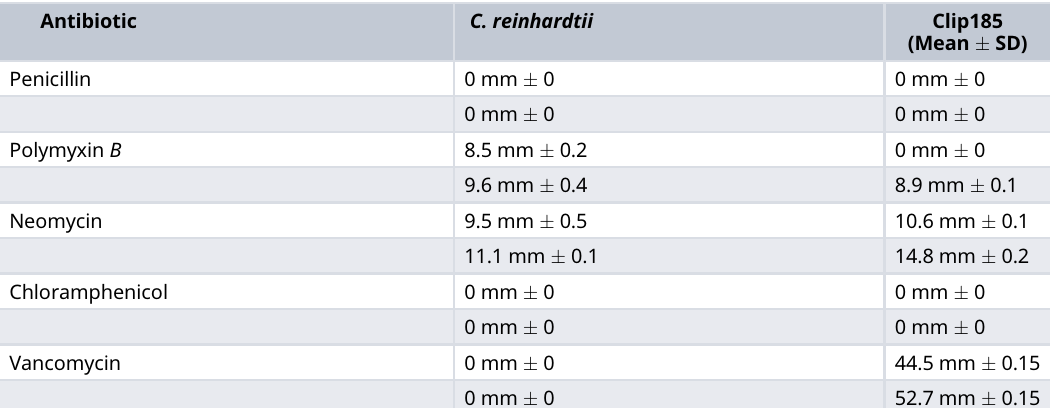
Table 1. Mean diameters of zones of growth inhibitions obtained from disc-diffusion antibiotic susceptibility tests. Zones of growth inhibitions in the presence of five different antibiotics (Penicillin, Chloramphenicol, Neomycin, Polymyxin B and Vancomycin) were studied for Chlamydomonas reinhardtii and the bacterial strain, Clip185. Grey and white rows represent 50 μ g and 100 μ g of each antibiotics applied on the filter paper discs, respectively. Three biological replicates (each had three internal replicates) were used to calculate means and standard deviations shown in the table. Statistical analyses are available as Underlying data.